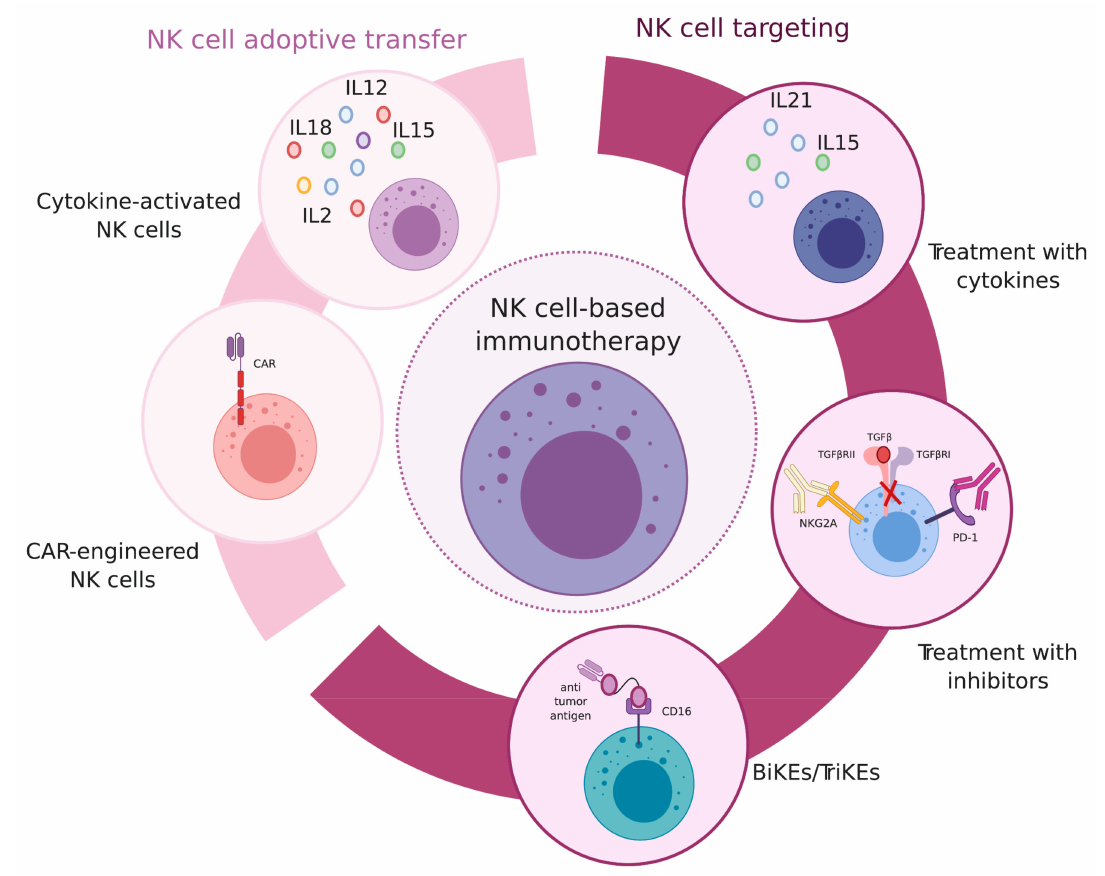
Figure 2. NK cell-based immunotherapy strategies. Different therapeutical approaches that were recently developed to enhance NK cell anti-tumor potential. From the right part, treatments to promote NK cell function: treatment with cytokines to promote NK cell activation; treatment with antibodies or inhibitors to block NK cell inhibitory receptors or inhibitory pathways; NK cell engagement via the bi/tri-specific molecules, simultaneously targeting NK cells and tumor antigens to link activating receptors in NK cells and tumors. From the left part, NK cell therapy: NK cell adoptive transfer, upon pre-treatment with cytokines; infusion with CAR-NK